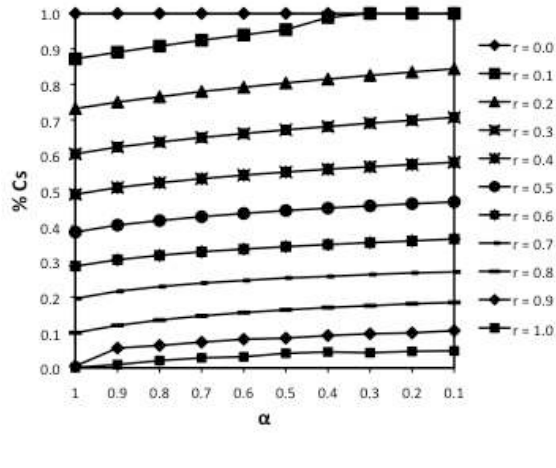
Fig. 5. Proportion of Cs for the SD game on SFNs with m = 4 and with K = 1 / 8. The average D value is